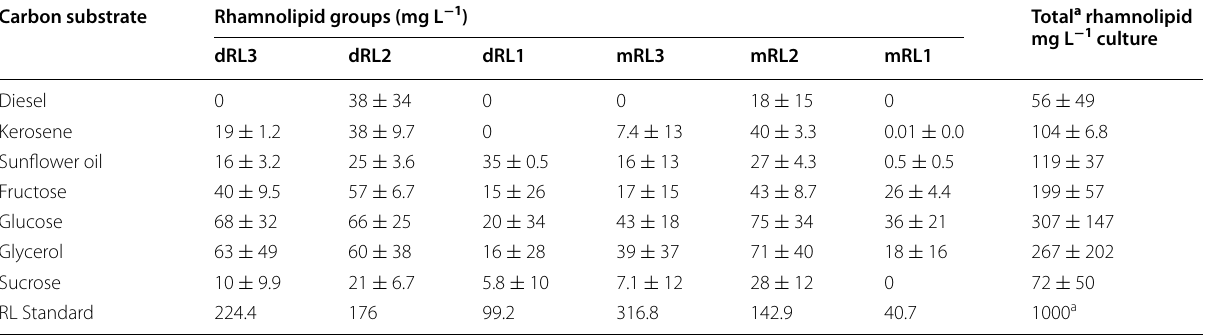
Each value represents the average of three culture extracts with standard error of the mean (SEM) a Approximate values relative to detected signal in 1.00 mg L − 1 rhamnolipid standard